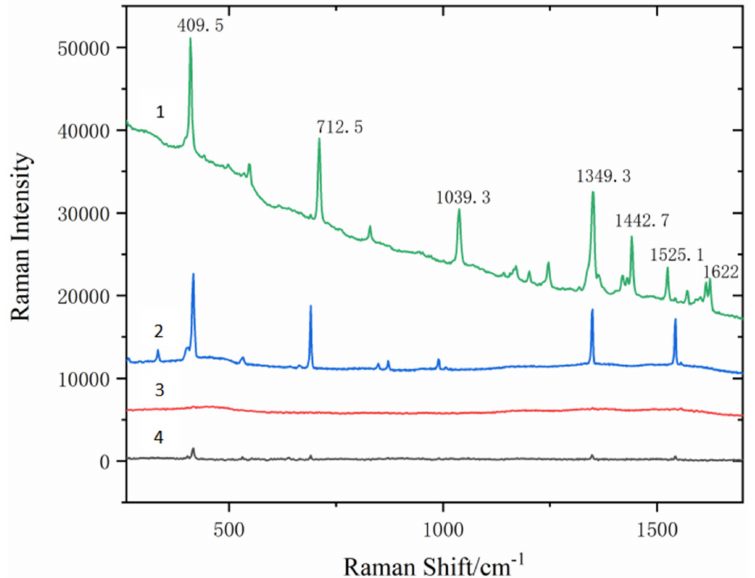
Figure 6. SERS signal of phenanthrene captured on Fe 3 O 4 @PDA@Ag@GO, Fe 3 O 4 @PDA@Ag, Fe 3 O 4 @PDA and Fe 3 O 4 , respectively (1) Fe 3 O 4 @PDA@Ag@GO substrate; (2) Fe 3 O 4 @PDA@Ag substrate; (3) Fe 3 O 4 @PDA substrate; (4) Fe 3 O 4